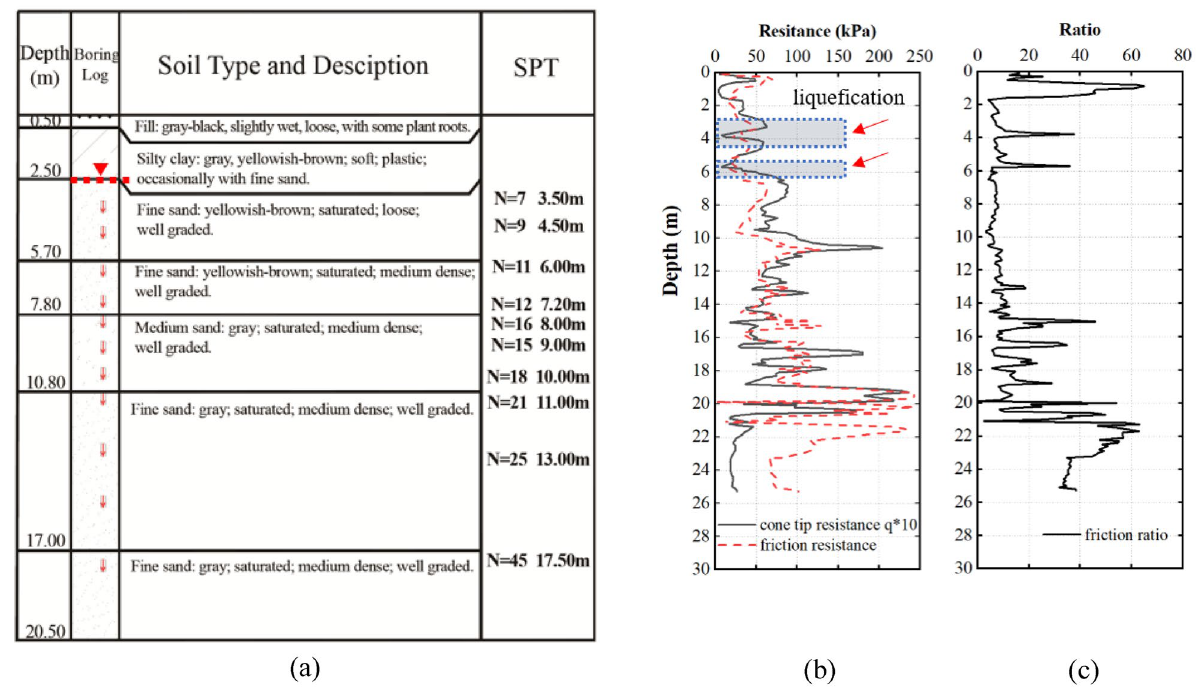
Figure 9. Soil profile ( a ), standard penetration test analysis ( b ), and cone penetration test analysis ( c ) of soil collected at liquefaction root, which spanned from 0 m to 0.5 m depth. Successively, the soil layer was filled with yellow and gray sand of medium and/or high fineness until the depth of 17.0 m, at which grayish-black silty clay layer was detected. Underneath the silty clay layer, a layer of fine yellow and gray sand was detected. Visual inspection upon drilling demonstrated a slight liquefaction of the fine yellow sand layer at the 6–7 m depth, which agreed to the SPT and CPT data presented in Fig. 10b,c. More interestingly, deep liquefaction was observed. Liquefaction at lower sand layer generated an upward movement of liquefied sand towards the clay layer at the 17 m depth, as visually dem- onstrated by the drilled sample (Fig. 10d). The occurrence of the deep sand liquefaction was further ascertained by the low value of cone tip resistance and lateral friction resistance at the depth between 18 and 19 m (Fig. 10b). Seed and Idriss 16,17 proposed a simplified calculation formula of sand liquefaction cycle stress ratio: